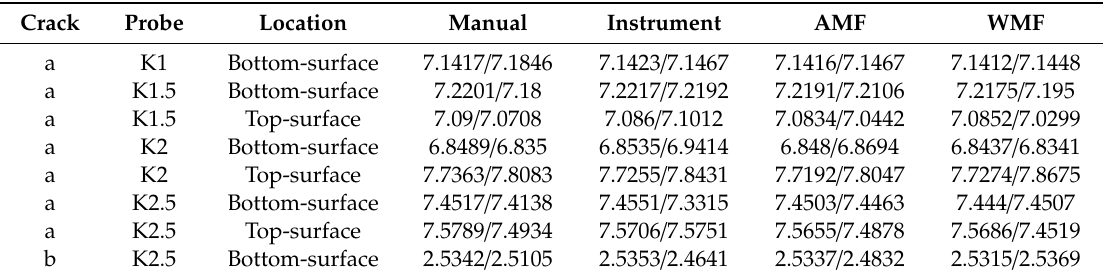
Table 8. The means of the flaws height of Monte Carlo simulation and experiments, (simulations / experiments), mm.